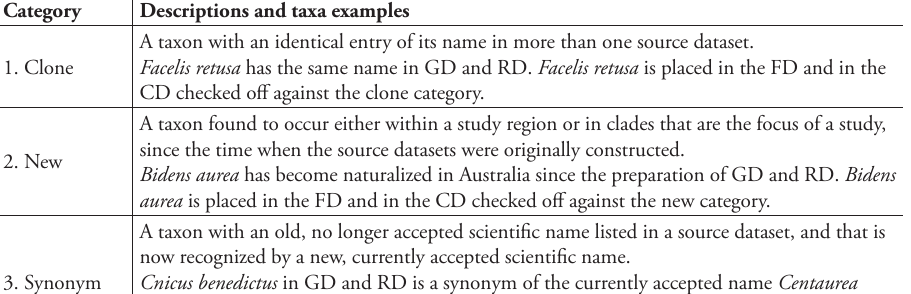
Table 1. Descriptions of the 10 categories in the companion dataset with examples of naturalized Asteraceae in Australia. FD = final dataset, CD = companion dataset, GD = Groves et al. (2003), RD = Randall (2007).